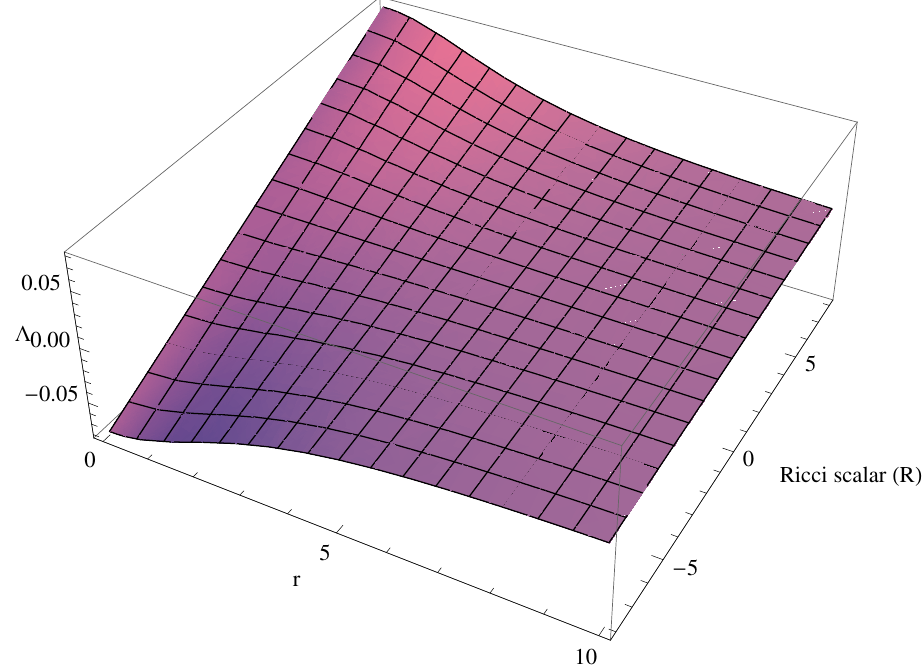
Figure 26. The behaviour of the cosmological constant in presence of perfect fluid matter source is shown against the Ricci scalar R with the values of the arbitrary constants λ = 0.1, C 3 = 2, C 4 = 0.001, C 5 =